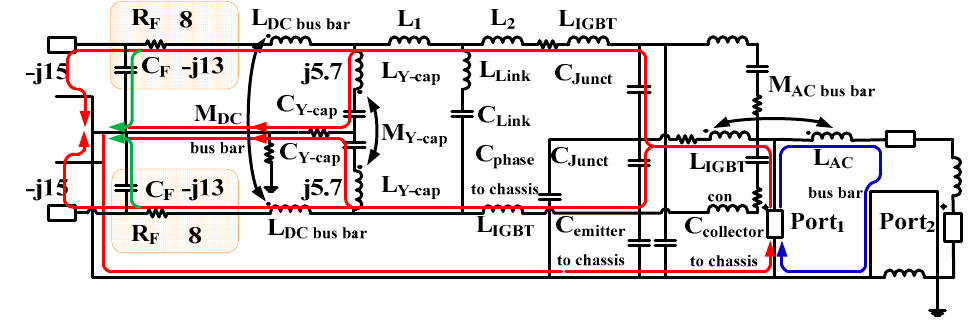
Energies 2016 , 9 , 419